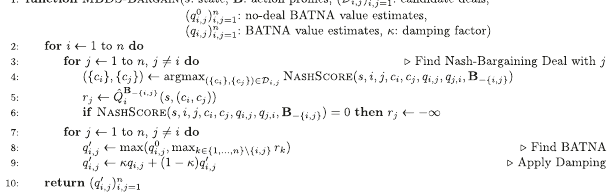
Algorithm 4 simulates an iterative process of updating beliefs